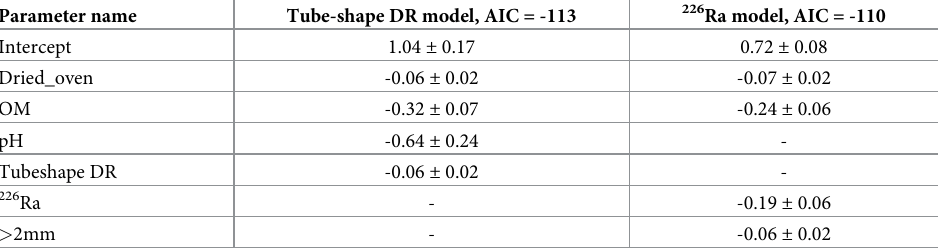
Table 6. Parameter estimates ( β ± SE) with the two best simplified linear models of log 10 litter loss, with log 10 transformation of fraction of organic matter (OM), pH, fraction of soil particle size > 2mm ( > 2mm), 226 Ra